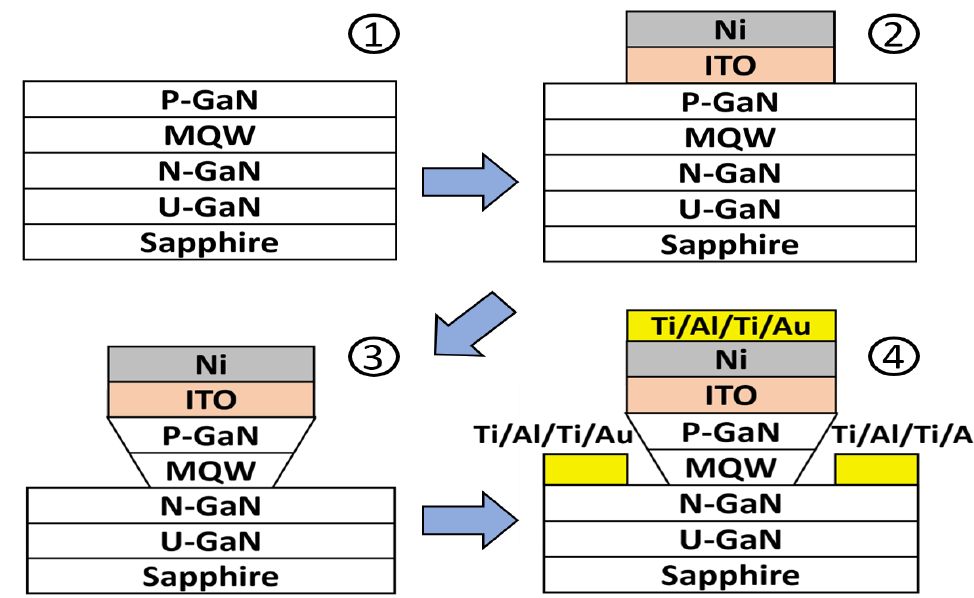
Figure 1. The schematic process steps of upside-down trapezoid mesa using the self-aligned process to avoid the metals depositing onto the mesa sidewall for the MicroLED array. At the last step, the common cathode and pixel anode can be directly deposited on the chip without lift-off process.